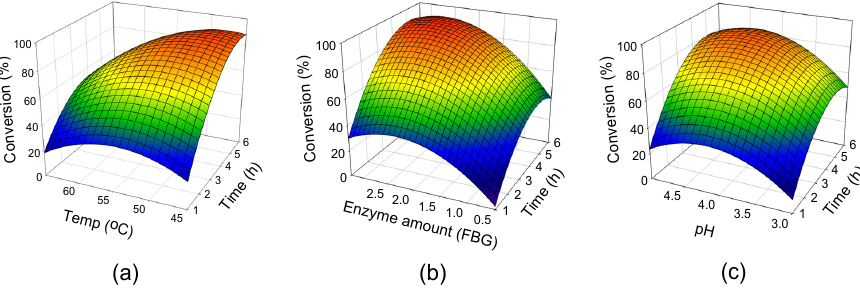
Figure 1. Response surface plot showing the relationships between resveratrol yield and reaction parameters: ( a ) reaction time and temperature; ( b ) reaction time and enzyme amount; and ( c ) reaction time and pH.